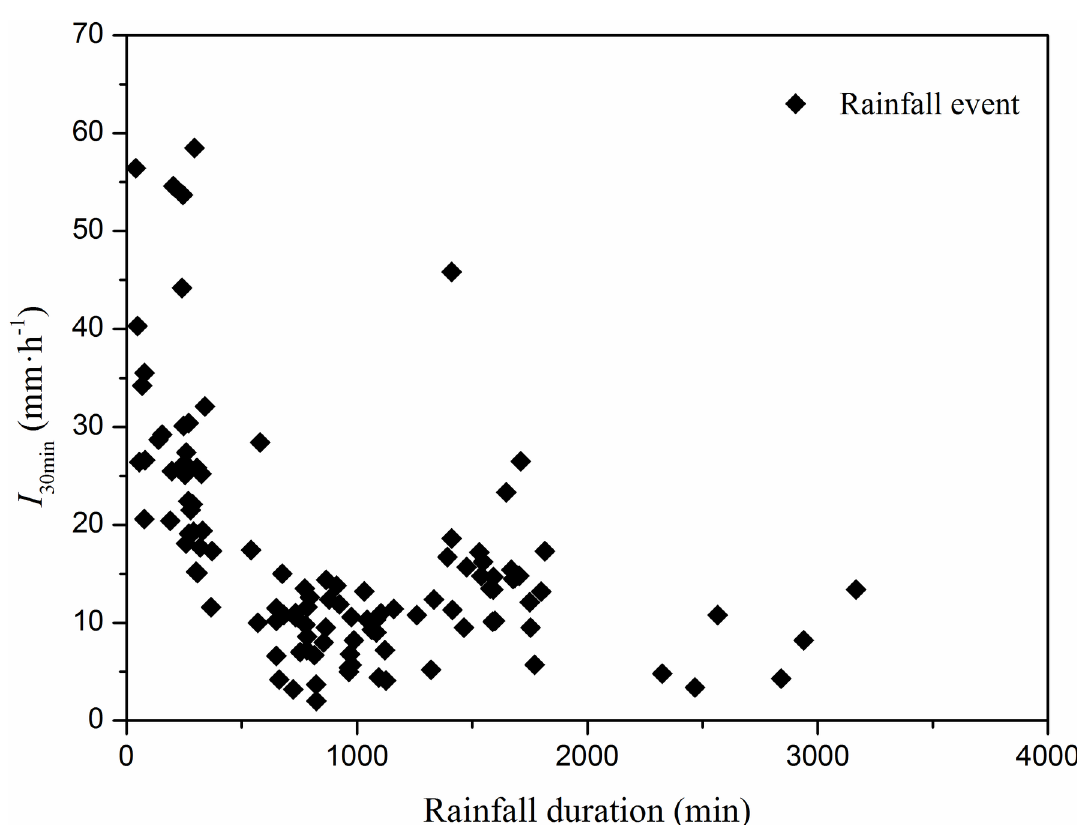
Fig 3. Relationship between maximum 30 min intensity and duration of the 144 rainfall events.